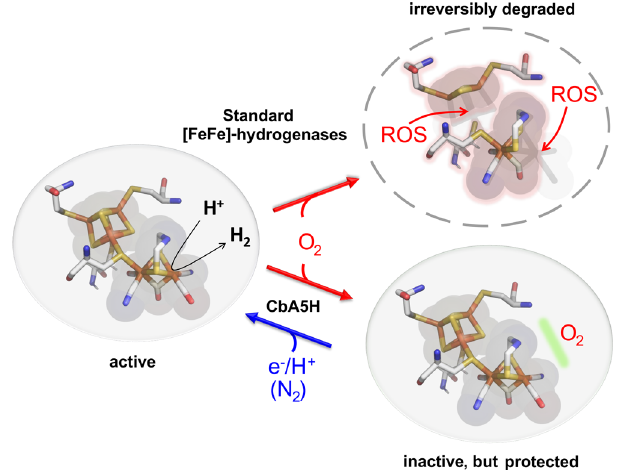
Fig. 1 The unusual O 2 -resistance of [FeFe]-hydrogenase CbA5H. The H- cluster of CpI and other [FeFe]-hydrogenases is irreversibly destroyed when exposed to O 2 . CbA5H is a rare exception, as it reversibly converted into an inactive but O 2 -protected state (H inact ), even in the absence of exogenous sul fi de. From the O 2 -protected state, CbA5H can be reactivated by reduction under anaerobic conditions. ROS: reactive O 2 -species resulting from O 2 -activation after Fe d -binding. Green bar: unknown feature or mechanism, protecting the H-cluster of CbA5H from O 2 -attack in H inact